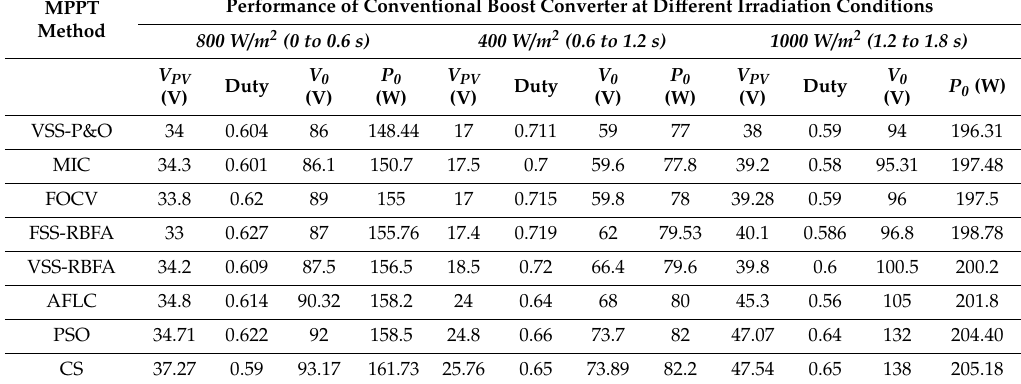
Table 6. Performance results of CBC at different irradiation conditions (0.8, 0.4, and 1 kW/m 2 ). MPPT